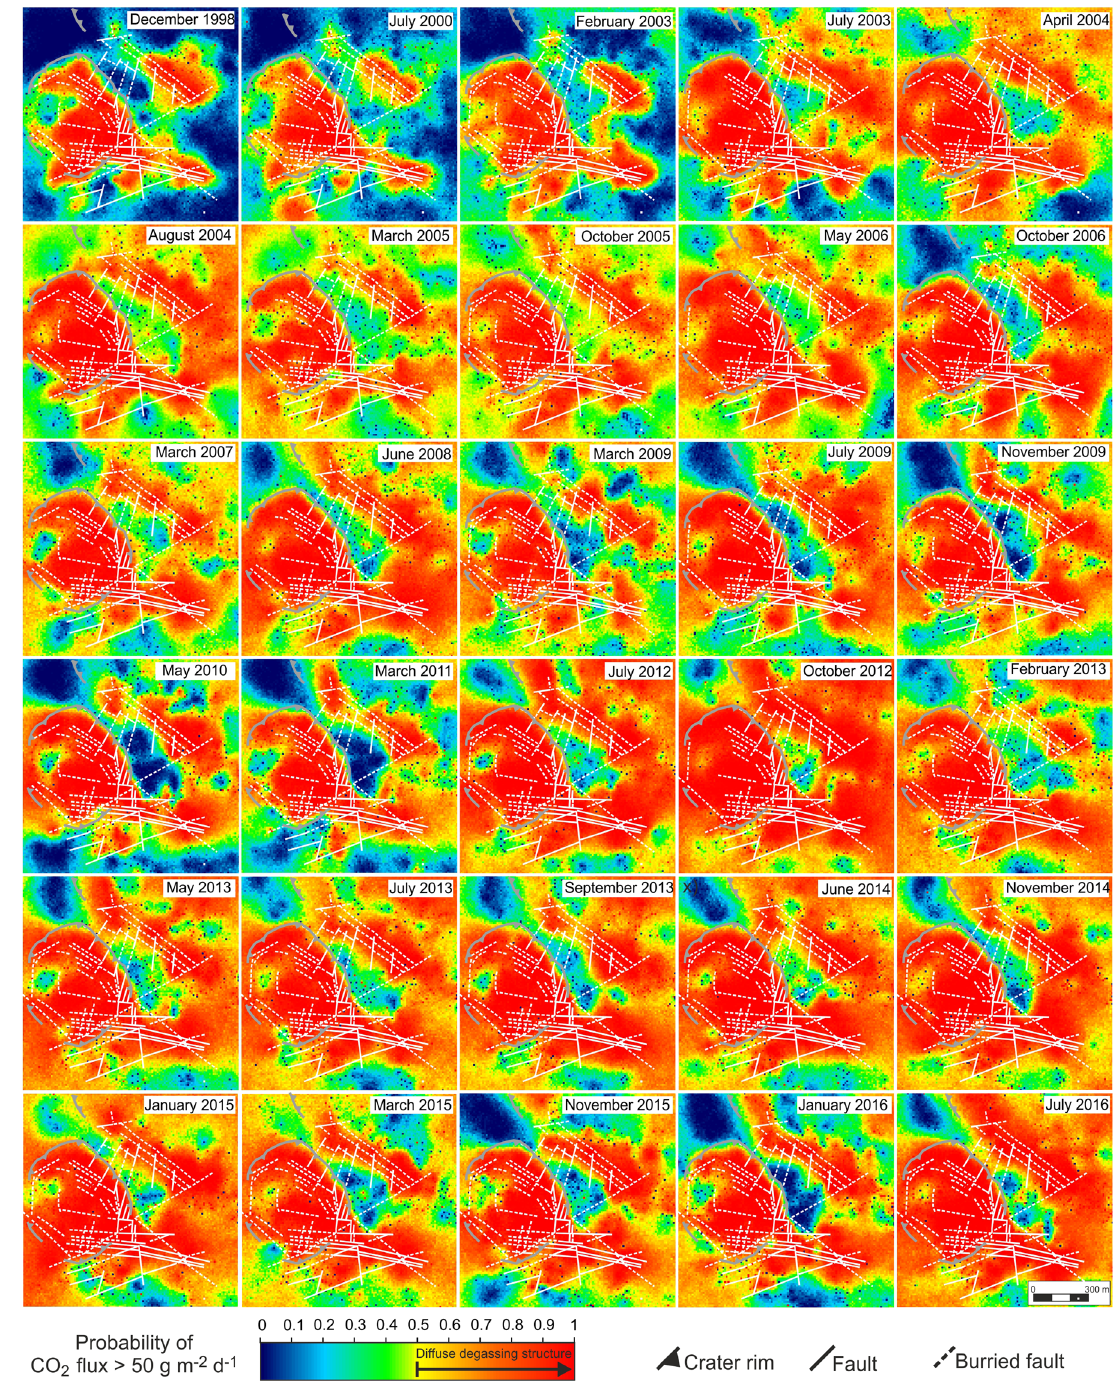
Figure 5. Maps of Solfatara diffuse degassing structure (DDS) in the 1998–2016 period. The maps report the probability that the simulated CO 2 flux is greater than 50 g m − 2 d − 1 , selected as the threshold for a pure biogenic CO 2 flux. Yellow to red colours i.e., probability of CO 2 Flux > 50 g m − 2 d − 1 is higher than 50% define the Solfatara DDS where degassing deeply derived CO 2 occurs. Tectonic structures are from ref. 60. The maps were realized with the software Surfer, Version 11.0.642